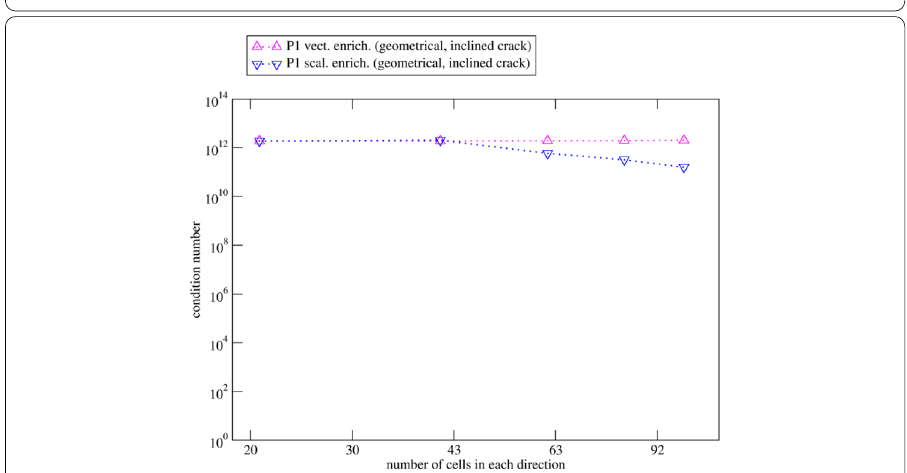
Fig. 24 Boundary conditions for an inclined crack. The boundary conditions are the same with the horizontal crack test